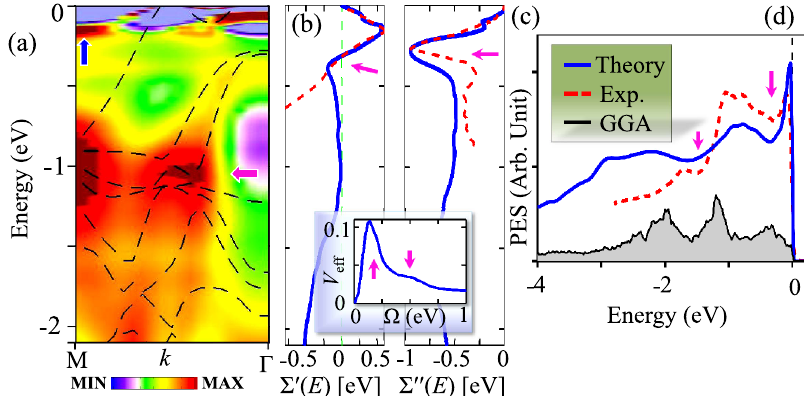
FIG. 3. Theoretical study of the spin-fluctuation-dressed dispersion anomaly. (a) Spectral-function intensity map versus energy and momentum along M ! (cid:1) . The black lines are the corresponding ab-initio bands. The arrows mark the two energy scales of highest intensity, as in Fig. 1(a). (b) The real part of the momentum and orbital averaged self-energy (blue line) compared with the experimental data (red dashed line). The experimental curve is multiplied by a factor of 5 for better visualization, because it is derived from a linear slope. The green dashed line marks the zero-energy axis. (c) The imaginary part of the self-energy shows a peak at the same energy where the experimental linewidth also has a peak. The inset shows the spin-fluctuation interaction potential responsible for the structures seen in the self-energy. (d) Computed partial PES (integrated over momentum between (cid:1) and M) shows multiple peaks, as in the experimental curve [red dashed lines, taken from Fig. 1(e)]. The black line is the corresponding (normalized) GGA density of states. The red arrows mark the depletion of states, originating from the spin-fluctuation